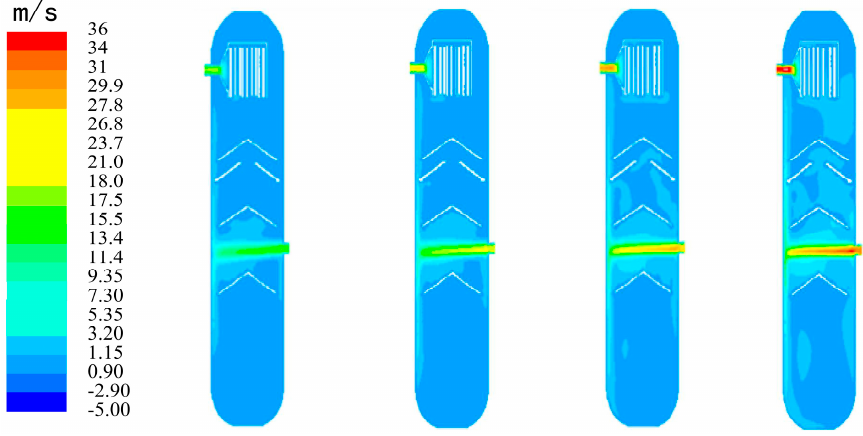
Figure 4. Velocity profile under different entrance velocities.